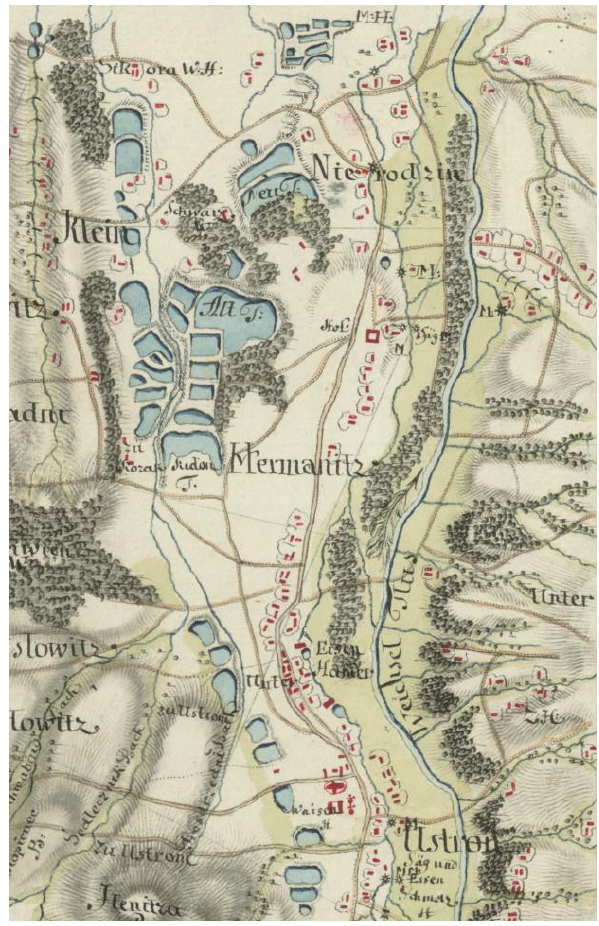
Fig. 1. The Ustroń settlement (of the waldhufendorf type) situated on a meadow terrace and the complex of ponds in the River Vistula valley (according to General-Mappa des…,